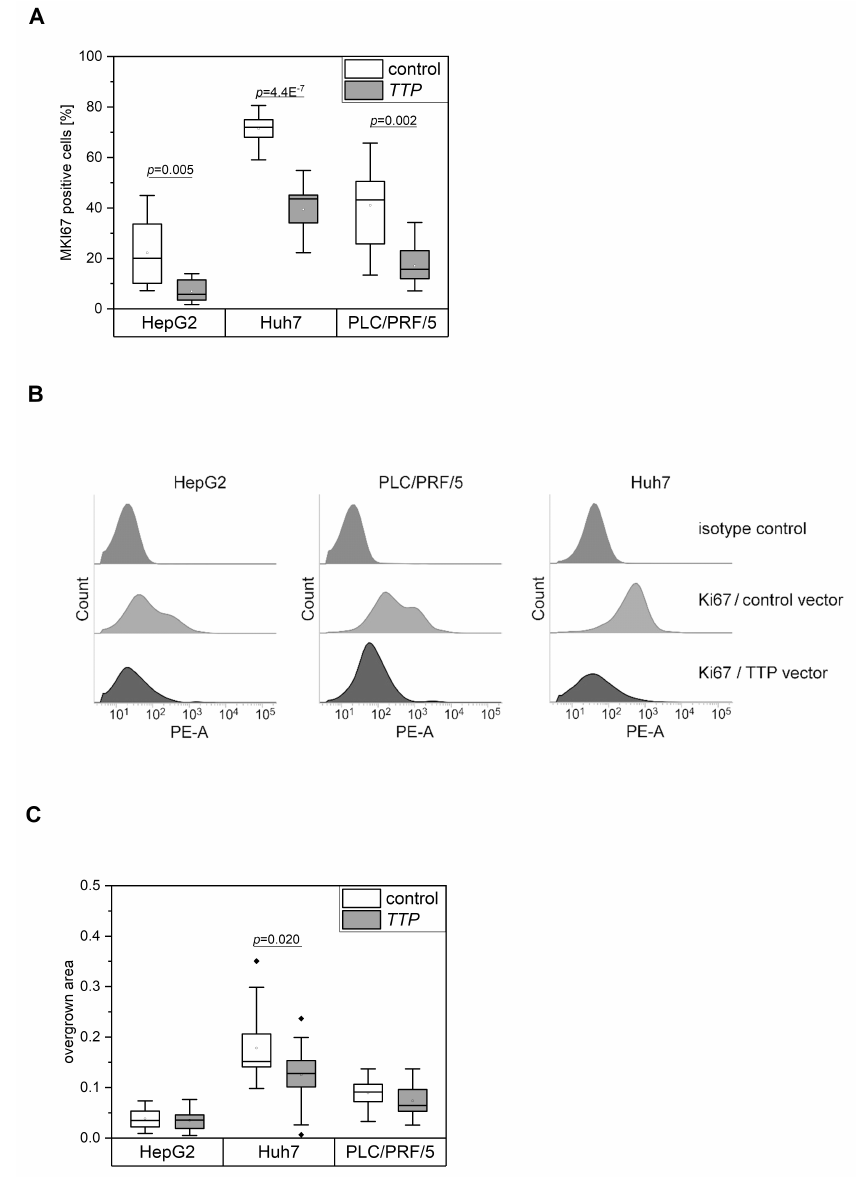
Figure 4. Proliferation and migration of TTP-overexpressing hepatoma cells. ( A ): Proliferation of cells transfected with either TTP (gene name ZFP36 ) or a control vector. ( B ): Flow cytometric analysis of the proliferation marker MKI67 in TTP-overexpressing ( TTP vector) and control cells (control vector). The isotype controls represent the control cells. Representative histograms of MKI67 flow cytometric analyses are shown. n = 3; triplicates. ( C ): Migration of HepG2, Huh7, and PLC / PRF / 5 cells transfected with either a TTP or a control vector. The di ff erence between the open image area t(0) and t(24) was considered as an overgrown area. n = 5–6; quadruplicates. Statistical di ff erence: *: p ≤ 0.05; **: p ≤ 0.01; ***: p ≤